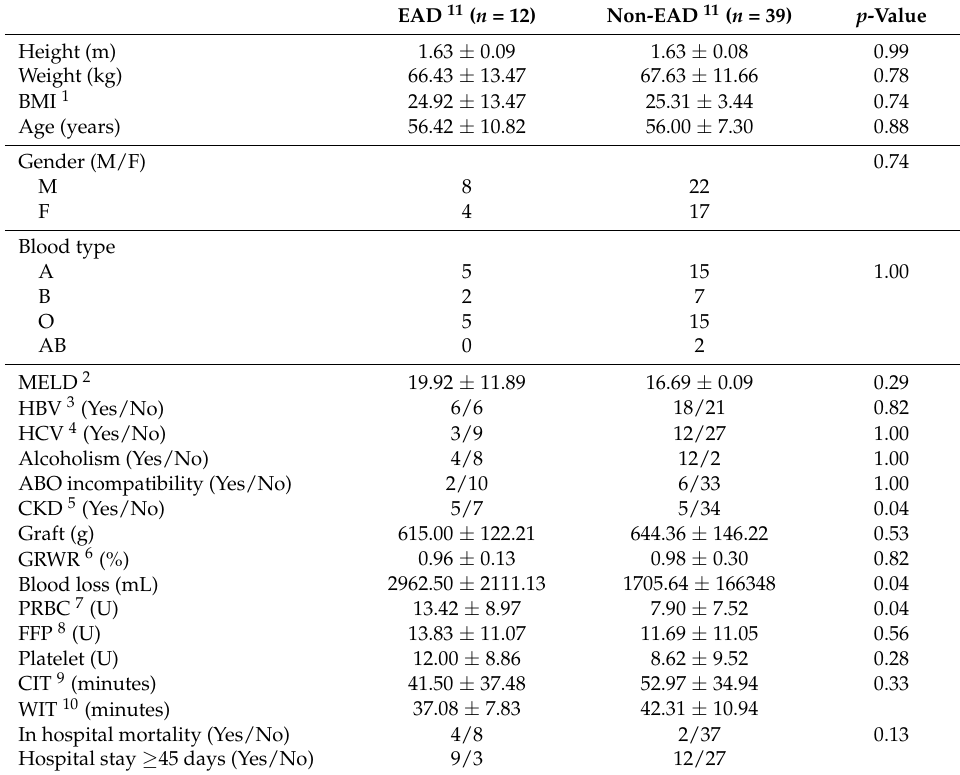
Table 1. Summary of clinical data for living donor liver transplantation